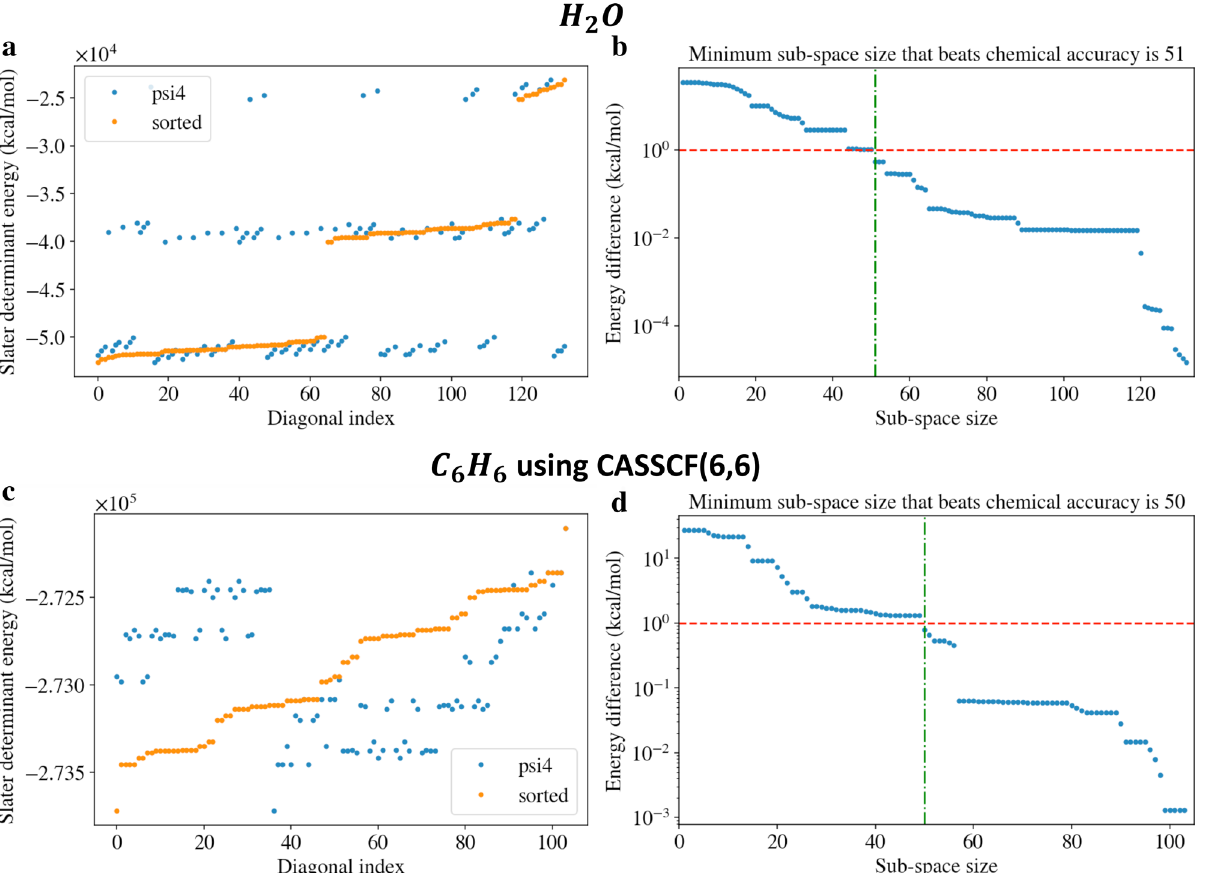
Figure 7. The sorted energy approach is demonstrated for H 2 O and C 6 H 6 . ( a ) The SDs for H 2 O in sorted order are shown displaying distinct energy levels. ( b ) The minimum number of SDs required to be within chemical accuracy, 51, is shown. ( c ) The sorted SDs for C 6 H 6 are shown, somewhat separated in energy. ( d ) The minimum number of SDs within chemical accuracy, 50, is